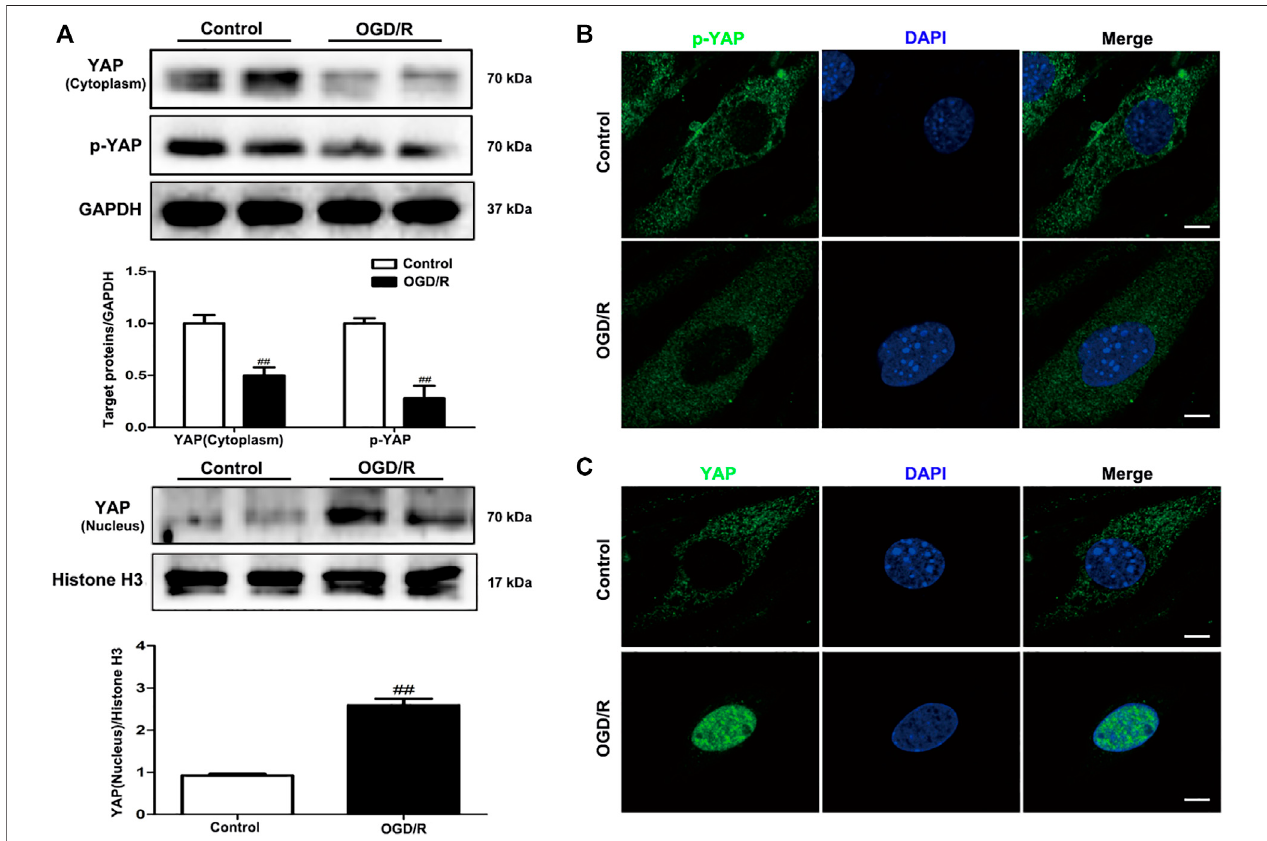
FIGURE 5 | Expression levels of YAP/p-YAP in brain endothelial cells following OGD/R-induced injury. bEnd.3 cells were exposed to 6 h of OGD and 6 h of reoxygenation. (A) OGD/R-inducedchangesinYAP/p-YAPproteinexpressionlevelsinthecytoplasmandnucleus,asdetectedbywesternblottinganalysis. (B) and (C) OGD/R-induced changes in YAP/p-YAP protein expression levels were detected by immuno fl uorescence using a combination of anti-YAP (green), anti-p-YAP (green), and DAPI (blue) staining in bEnd.3 cells. Scale bar (cid:1) 50 µm. Data are expressed as the mean ± SD, n (cid:1) 3. ## p < 0.01 vs . Control group.